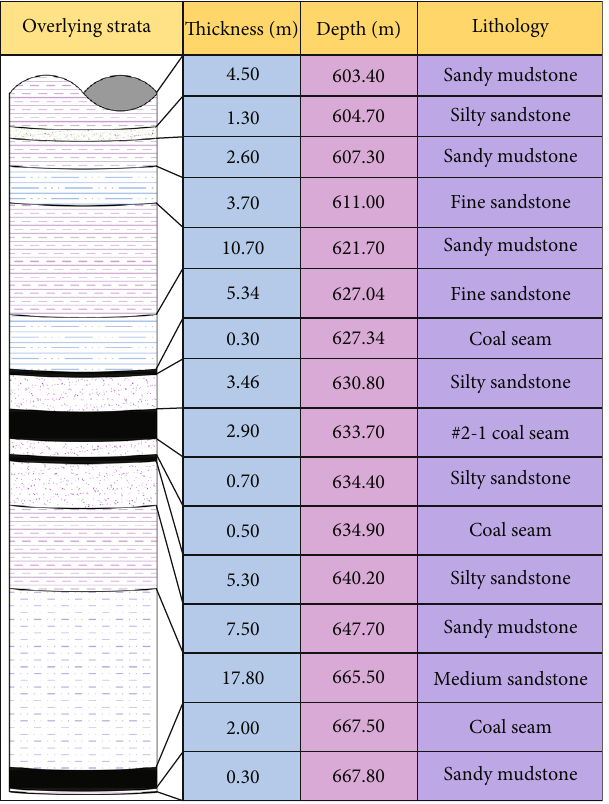
Figure 1: The stratigraphic synthesis column of study area.